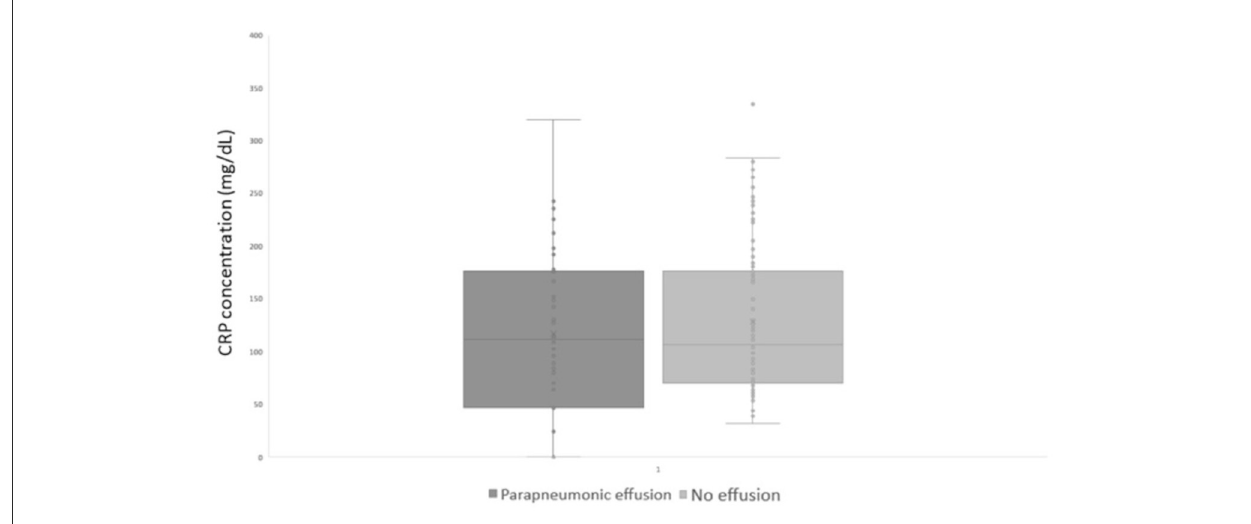
FIGURE5 CRP at diagnosis in dogs with and without parapneumonic effusion. CRP, Serum C-Reactive protein.